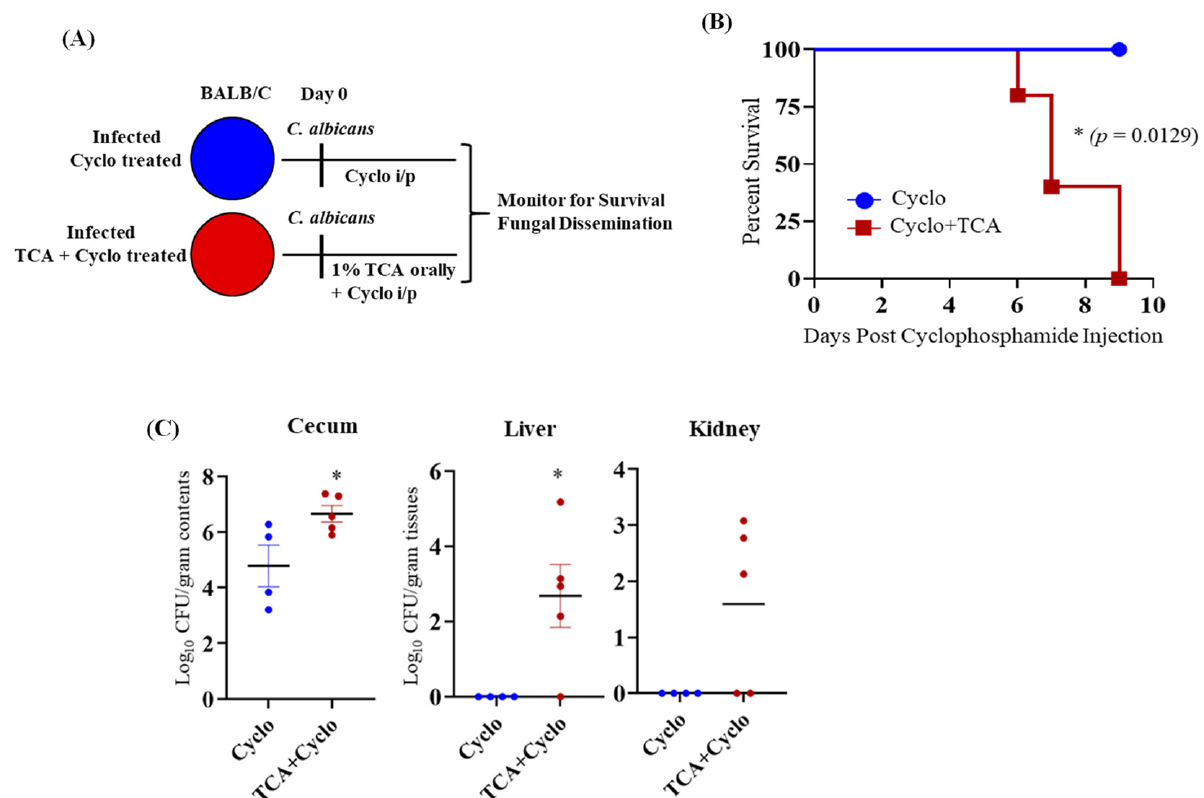
Figure 3. TCA induces fungal dissemination from the GI tract of immunosuppressed mice in the absence of antibiotic treatment. ( A ) Experimental outline. BALB/c mice infected with ~2 × 10 8 CFU CA SC5314 via oral gavage received sterile water containing or not containing 1% TCA. Three days post-infection, all mice were injected with three doses of cyclophosphamide intraperitoneally (150 mg/kg body weight). ( B ) Mice were monitored for survival, and a log-rank test was performed using 95% confidence intervals; statistical significance was calculated to compare the antibiotic-treated and untreated control groups. ( C ) Fungal load from cecum, liver, and kidney collected immediately after death in the TCA+ cyclo-treated groups and mice euthanized 9 days post-infection for cyclo groups. 4–5 mice per group were used, and the data represent mean ± SEM. Statistical significance was evaluated using the Mann–Whitney U test. p values ≤ 0.05 (*) was considered statistically significant.